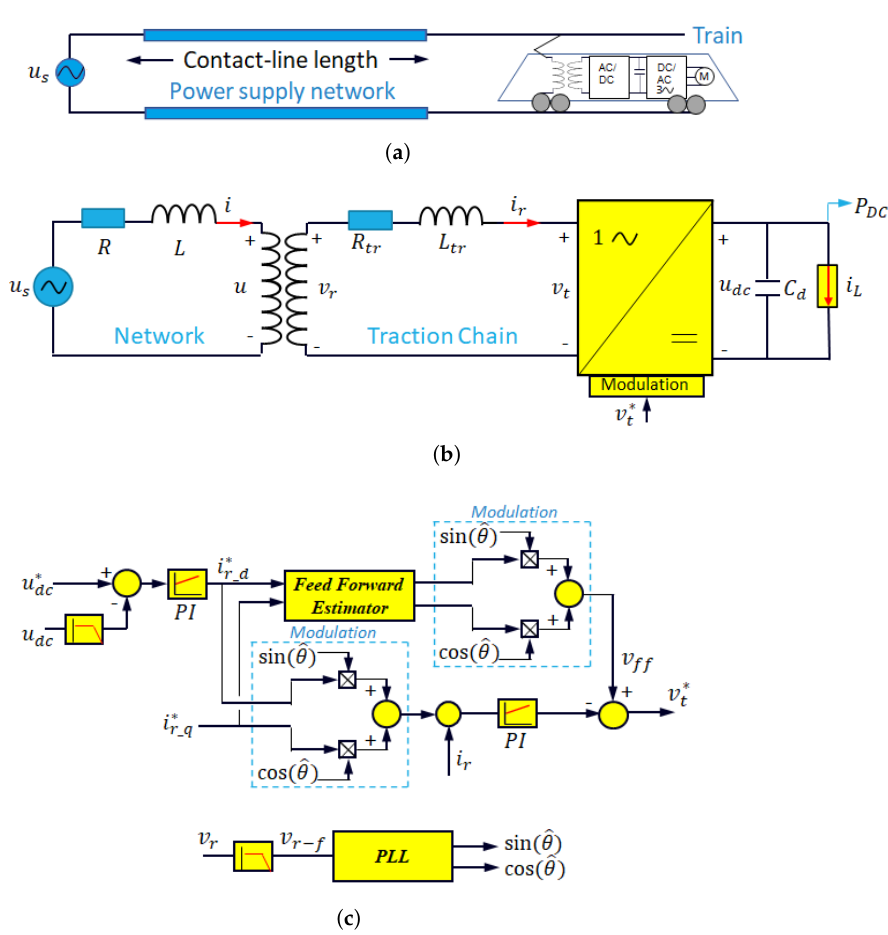
Figure 2. Railway system model and control. ( a ) Railway traction power system, ( b ) Simplified railway system model for the study of LFO. ( c ) Traction chain control